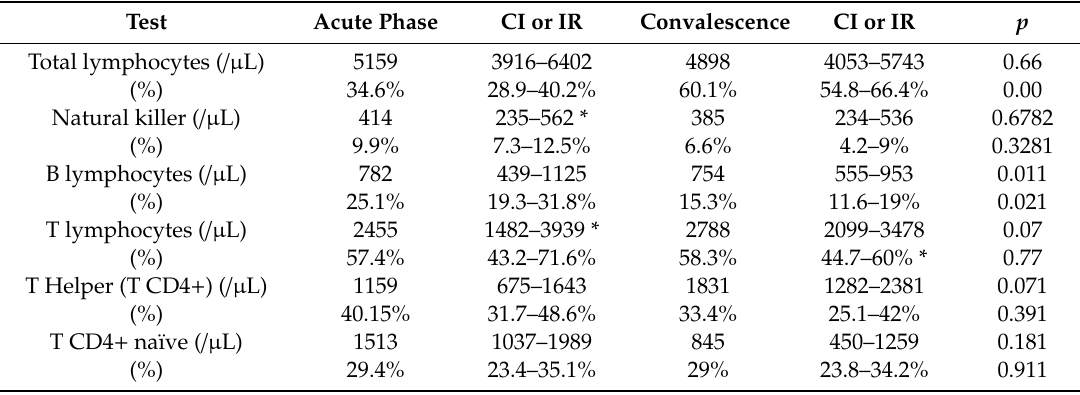
Table 4. Lymphocytes population expressed in concentration and percentage of total lymphocytes in 23 patients a ff ected by Adenoviral AURTIs during the febrile (acute) and afebrile (convalescence) phases, p values reflect di ff erence in